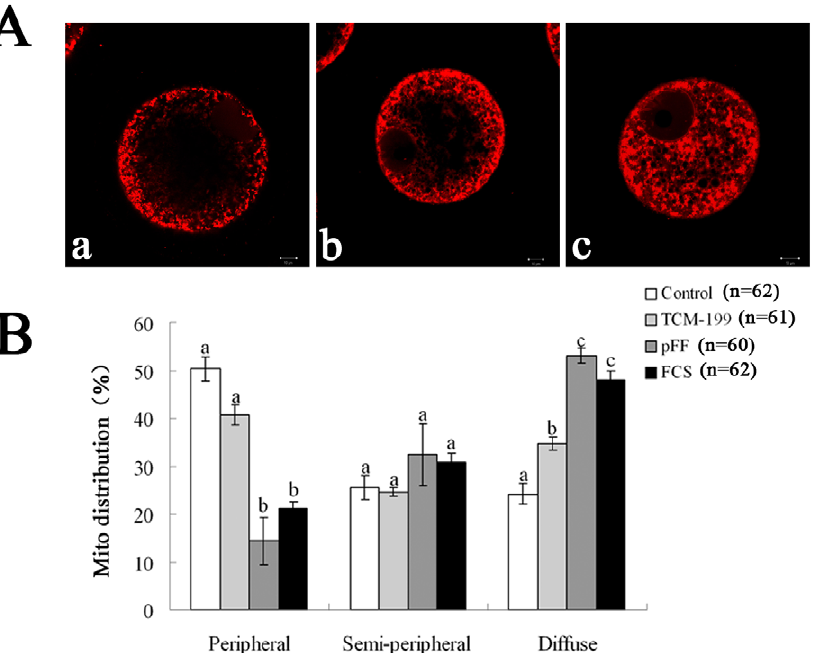
Figure 4. Effects of different media on mitochondria distribution in porcine oocytes after preservation. A. a, peripheral mitochondrial distribution, with no distribution at the center of the oocytes; b, semi-peripheral mitochondrial distribution; c, mitochondrial relocation and uniform distribution in the inner region of oocyte cytoplasm. Red, Mito Tracker Red staining. Scale bar =10 m m. B. Ratios of different mitochondria distribution patterns within the porcine oocytes after preservation with different media. Porcine oocytes were preserved in TCM-199, pFF and FCS at 27.5 u C for 3 d, and then mitochondria distribution was stained with MitoTracker Red CMXRos. Three categories of mitochondria distribution were detected: peripheral; semi-peripheral; diffuse. The graph shows the mean 6 SEM of three independent experiments. The number ‘‘n’’ in the bracket means the total treated oocyte in every group. The superscripts a, b, c over the bars represent values that differ significantly in every categories of mitochondrial distribution (P , 0.05).